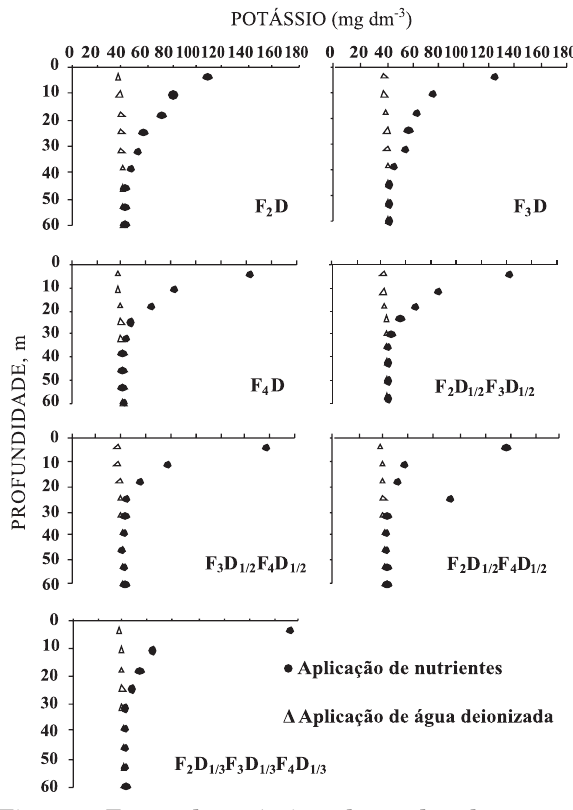
Figura 3. Teores de potássio ao longo de colunas com amostras do LVAd2, considerando a fração da lâmina de irrigação (F) em que o nutriente foi aplicado em dose integral (D) ou fracionado em duas (D ) ou em três vezes (D 1/2 1/3